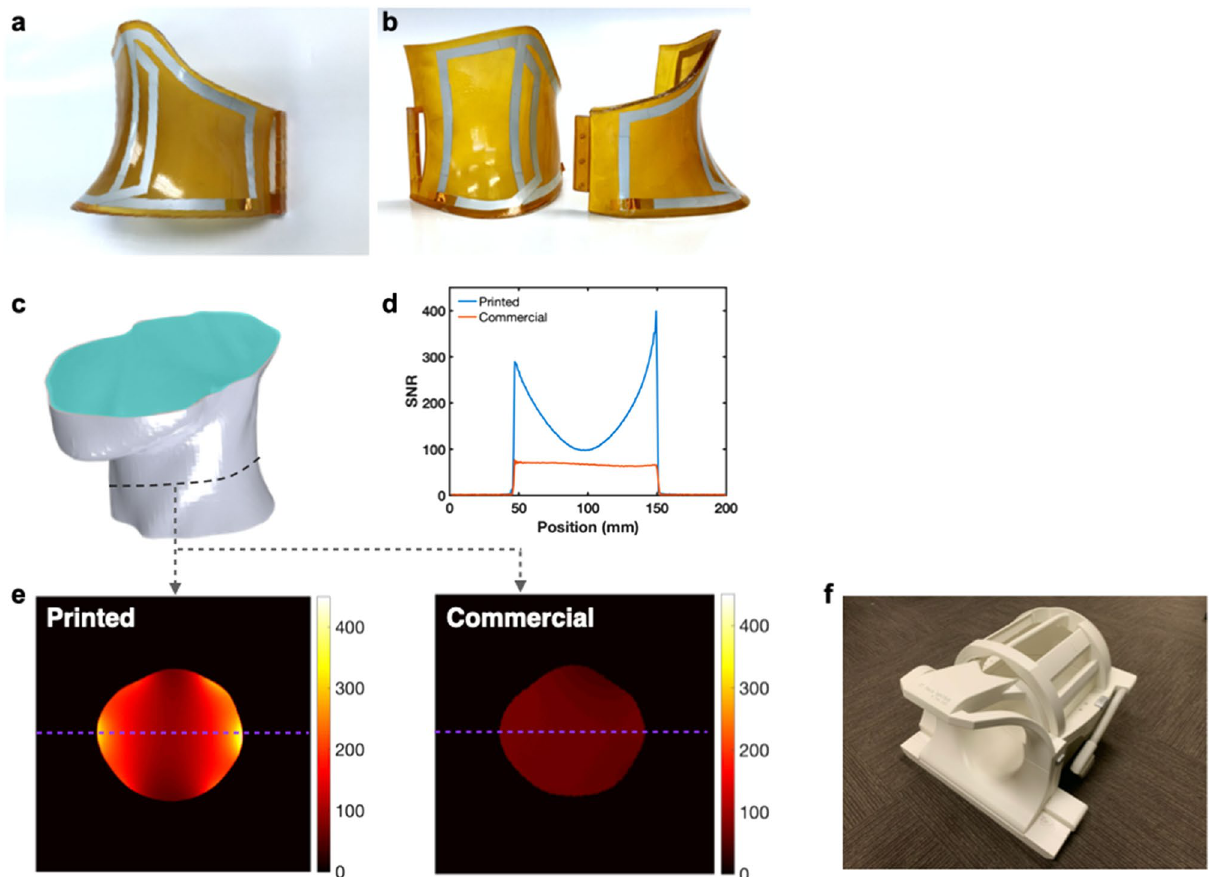
Figure 3. SNR from the custom coil array. ( a ) Photograph of the custom array fabricated by printing a pair of two-coil elements onto the custom substrate. ( b ) Photograph of the top custom arrays covering the entire neck surface area. ( c ) Schematics of the phantom consisting of 3D printed casing in a shape of the patient’s neck and containing solution of salts mimicking human tissue. ( d ) SNR of the printed and commercial coils along the cross-section of the slice through the middle of the neck. ( e ) SNR maps of the phantom using the printed and commercial arrays. Dashed lines indicate the location of SNR cross sections shown in ( d ). SNR was normalized to the maximum seen with the printed array. ( f ) Image of the commercially available 4 channel neck coil attached to a 12 channel head